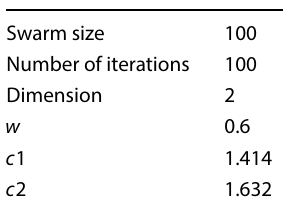
Table 3 Implementation parameters of